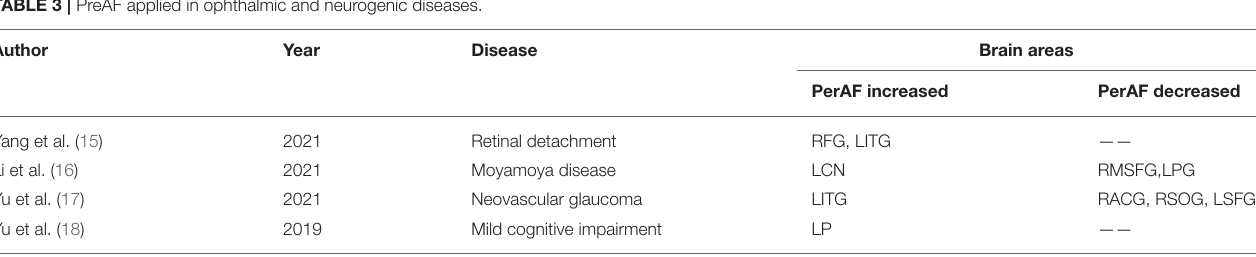
PerAF, percent amplitude of fluctuation; RFG, right fusiform gyrus; LITG, left inferior temporal gyrus; LCN, left caudate nucleus; RMSFG, right medial superior frontal gyrus; LPG, left precentral gyrus; LITG, left inferior temporal gyrus; RACG, right anterior cingulate and paracingulate gyrus, RSOG, right superior occipital gyrus; LSFG, left superior frontal gyrus; LP, left